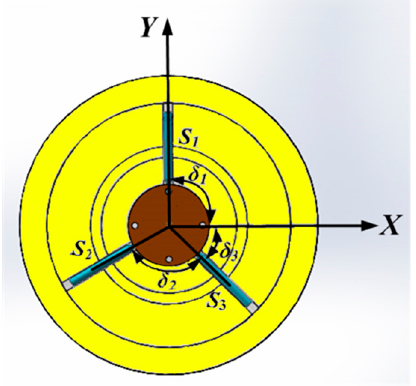
Figure 8. Placement diagram of the sensor.